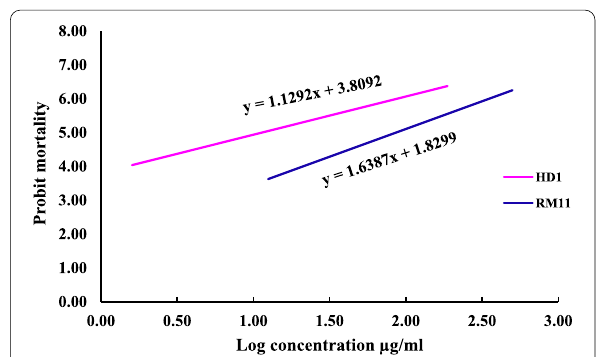
Fig. 7 Probit analysis of Bacillus thuringiensis isolates HD1 and RM11 for toxicity against Plutella xylostella larvae